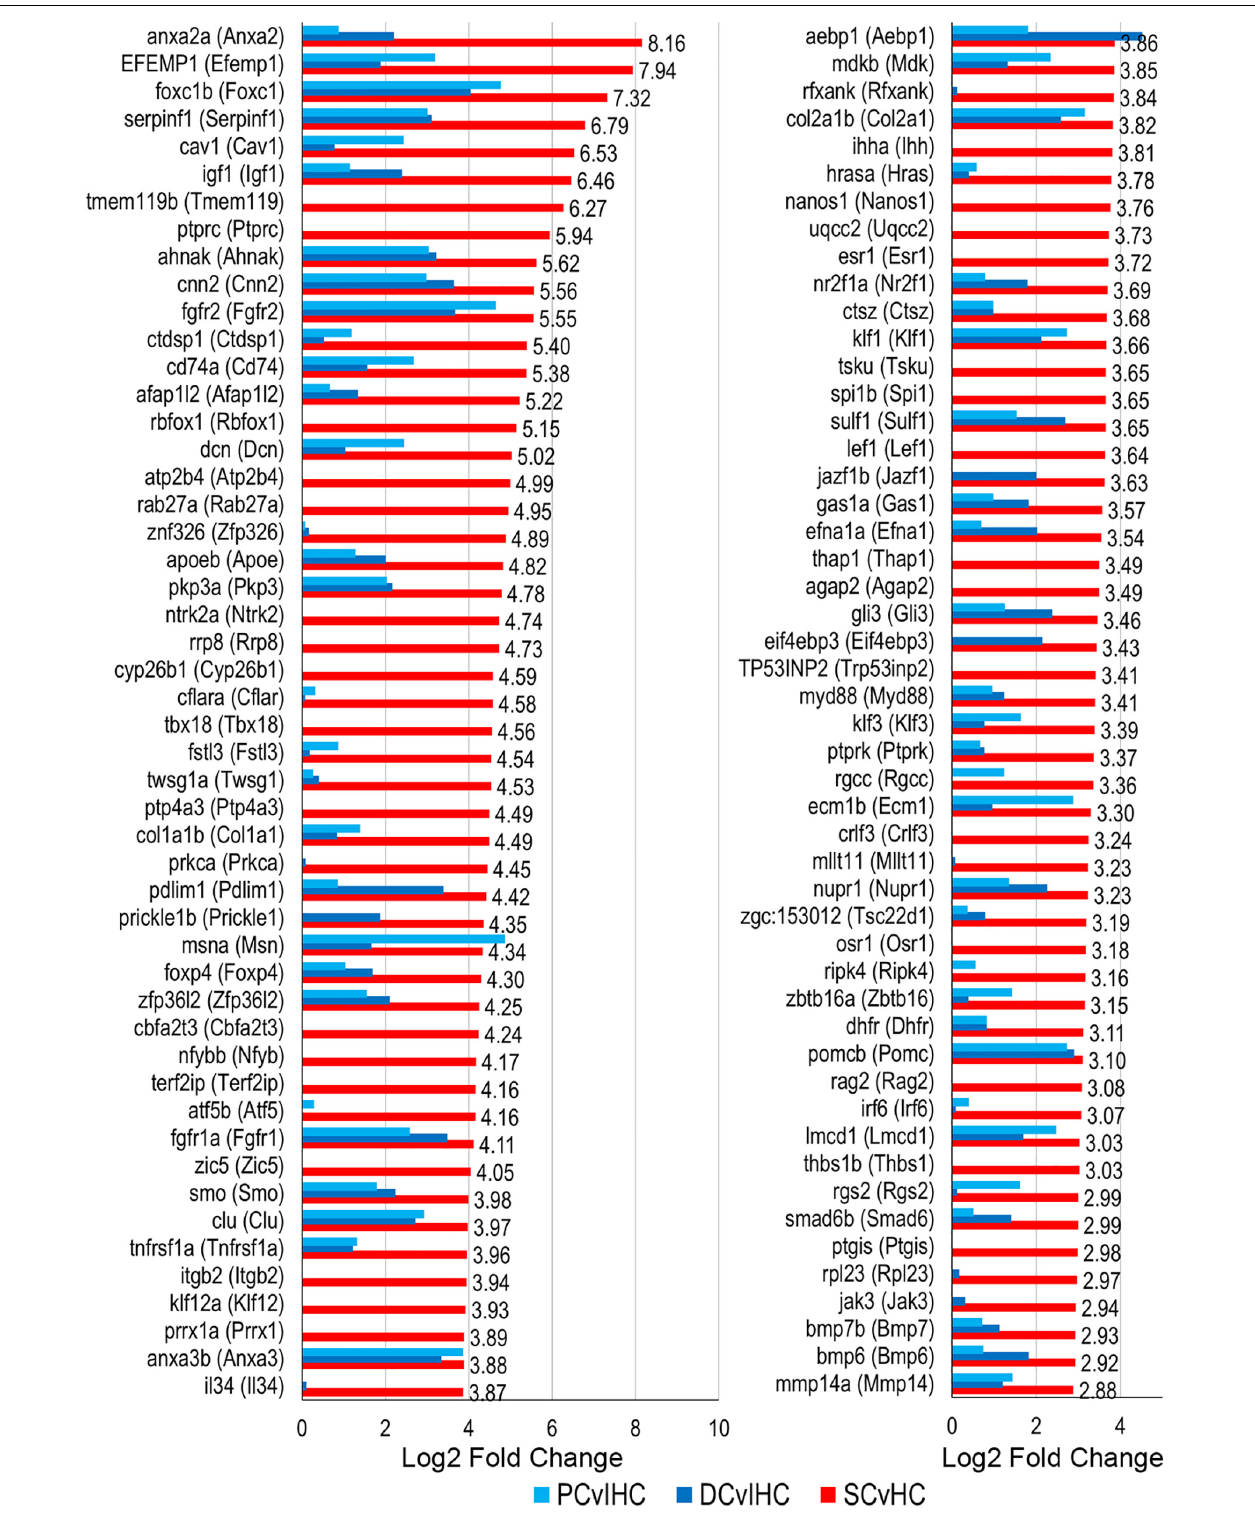
FIGURE 7 | Transcription factor gene expression among adult zebrafish nsSCs. Log2 fold change values of the top 100 ( n = 236) transcription factor genes upregulated in nsSCs compared to HCs (FDR-adjusted p -value ≤ 0.05, log2 fold change ≥ 1.0) (corresponding mouse gene ortholog name in parentheses). For comparison, fold changes for genes that are also upregulated in mouse PCs and DCs, compared to IHCs, are shown in blue.